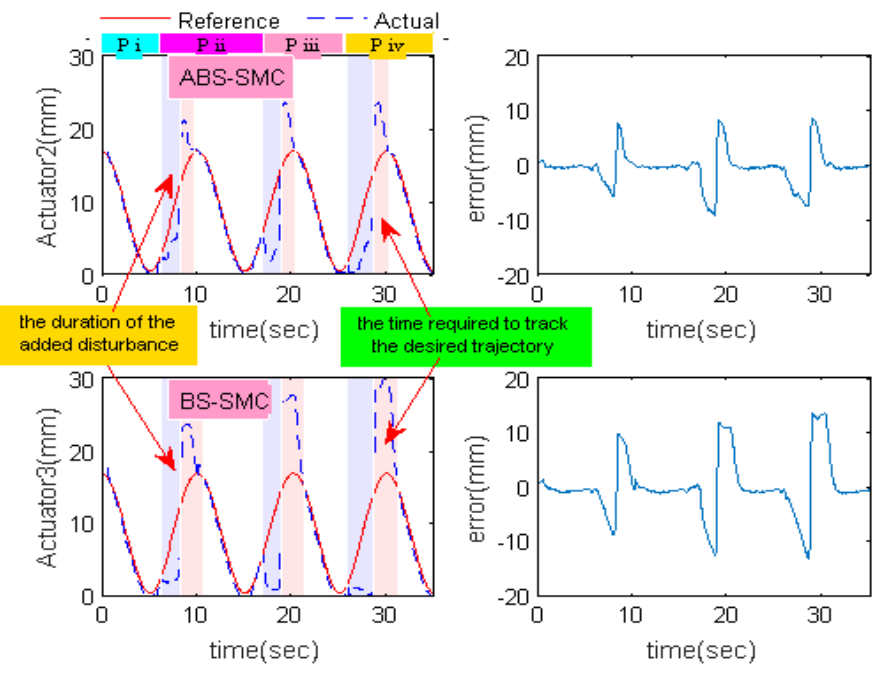
Figure 11. Actuator trajectory tracking results with abrupt disturbances. Table 6. Resistance force and duration of four phases in the experiment.